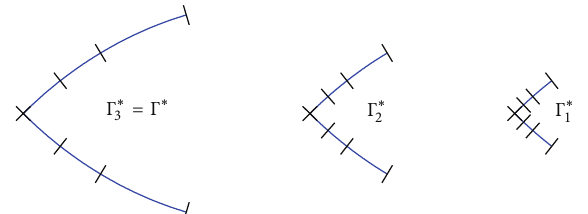
Figure 5: The boundary subsets Γ ⋆ 3 , Γ ⋆ 2 , and Γ ⋆ 1 along with their corresponding type b meshes for 𝑛